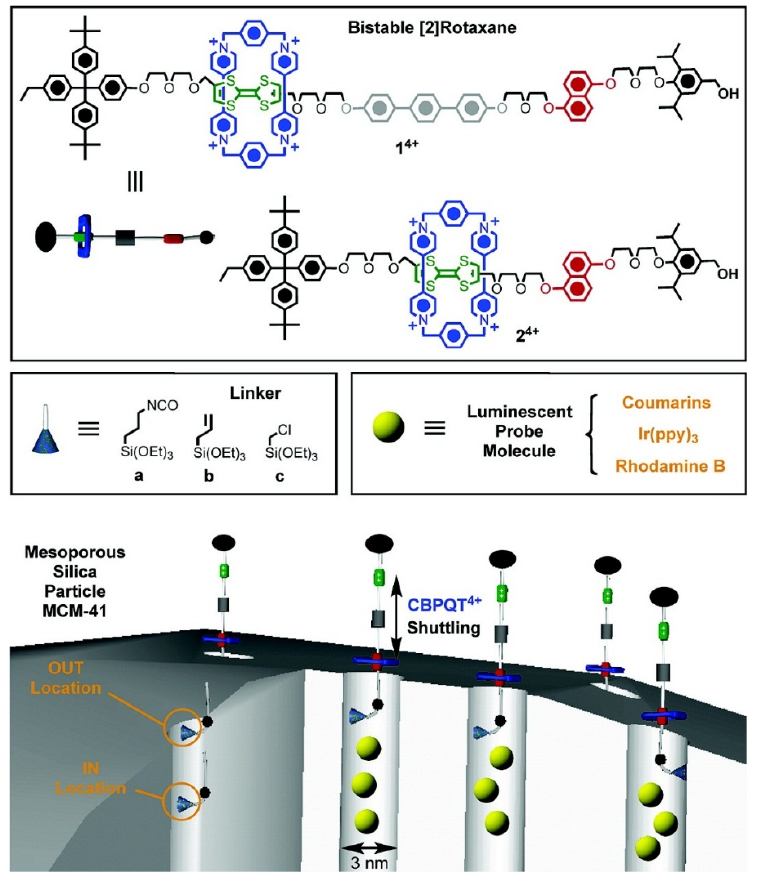
Figure 2. Depiction of the assembly of the components to form nanovalves with the structural formulas of the bistable [2] rotaxanes 1 4+ and 2 4+ , the three silane linkers a , b , and c used in this study, as well as the graphical representations of luminescent probe molecules and the possible positions (IN and OUT) of the linkers relative to the pore orifice. The pores are loaded when the valves are open and the probe molecules are trapped inside the pores when the valves are closed. The trapped molecules are released when the valves are reopened. The cycle can be repeated over and over again. Reproduced with permission from [28]. Copyright American Chemical Society,